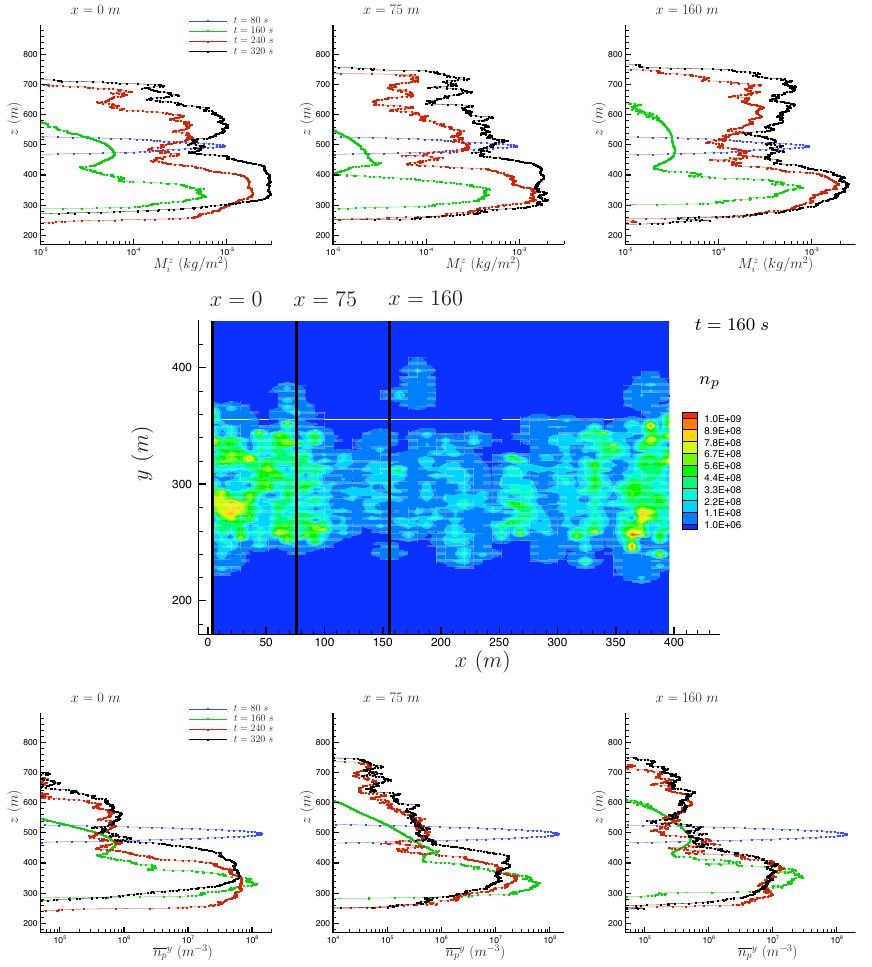
Fig. 9. Vertical profiles of ice mass (kgm − 2 ) (ice density integrated in y direction, top panels) and particle number averaged in y direction (m − 3 , bottom panels) at three axial locations and different wake ages (run V D 1). The middle panel shows the two-dimensional contour of number density m − 3 in the xy plane averaged in the vertical direction z